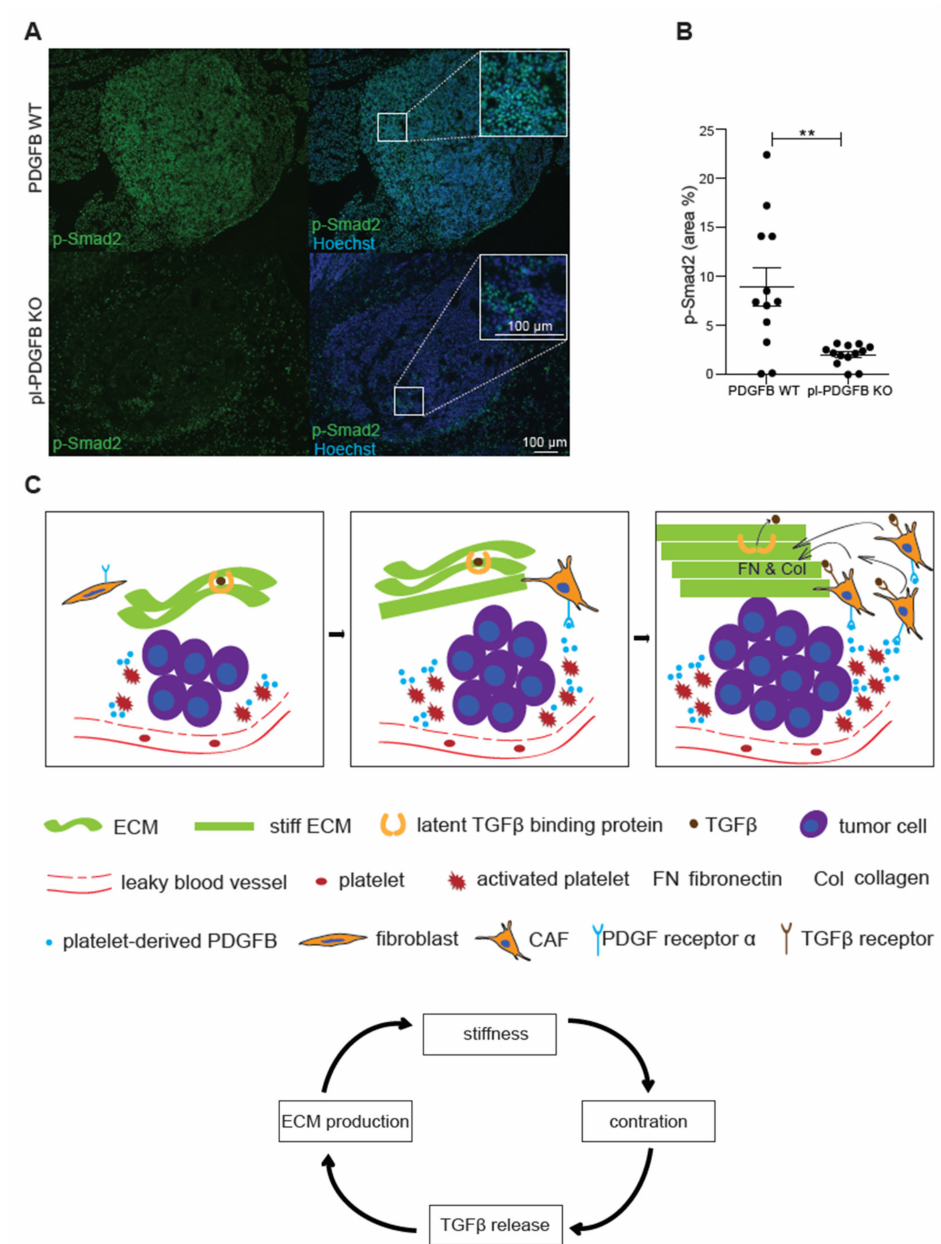
Figure 4. Reduced TGF β signaling in tumors from mice lacking PDGFB in platelets. ( A , B ) Tumors from 14-week old WT and pl-PDGFB KO RT2-positive mice were immunostained for p-Smad2 and the positive areas were quantified using Image J (WT n = 12; KO n = 13, ** p = 0.0015). Error bars in the graphs represent the standard error of mean (SEM). ( C ) Schematic model: the discontinuous endothelium in a tumor exposes platelets to subendothelial spaces, leading to activation, degranula- tion and release of PDGFB and other platelet-derived molecules in the tumor microenvironment (left panel). The PDGFR α + CAFs are recruited by PDGFB derived from platelets and other sources in the tumor microenvironment. CAFs express large amounts of ECM proteins such as Col1 and FN, which leads to increased stiffness of the ECM (middle panel). Increased cell contraction due to the stiffer ECM leads to more release of active TGF β from its extracellular stores, which in turn leads to more ECM expression and subsequently more FN polymerization (right panel). This process is creating a vicious circle (the arrow flow chart at the bottom): the more ECM production, the stiffer matrix and more release of active TGF β , a potent inducer of ECM